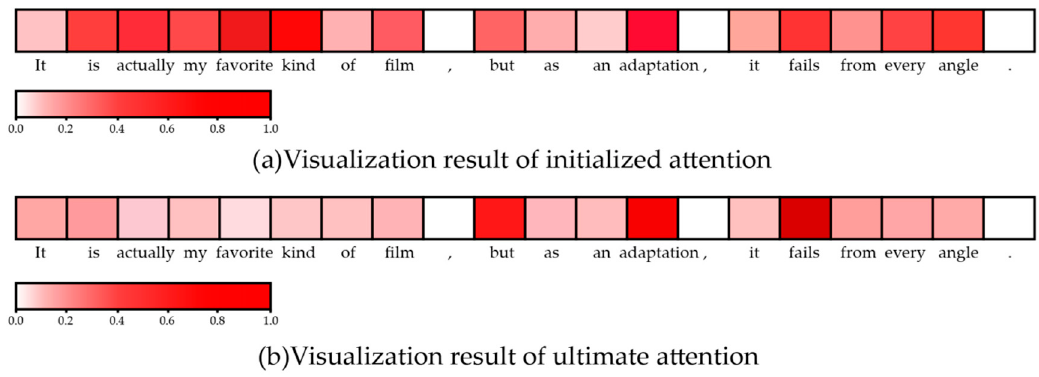
Figure 5. Comparison of initialized attention and ultimate attention. The attention score calculated by Equation (6) is used for the color-coding. The color depth indicates the importance degree of a word to the sentiment polarity of a sentence.